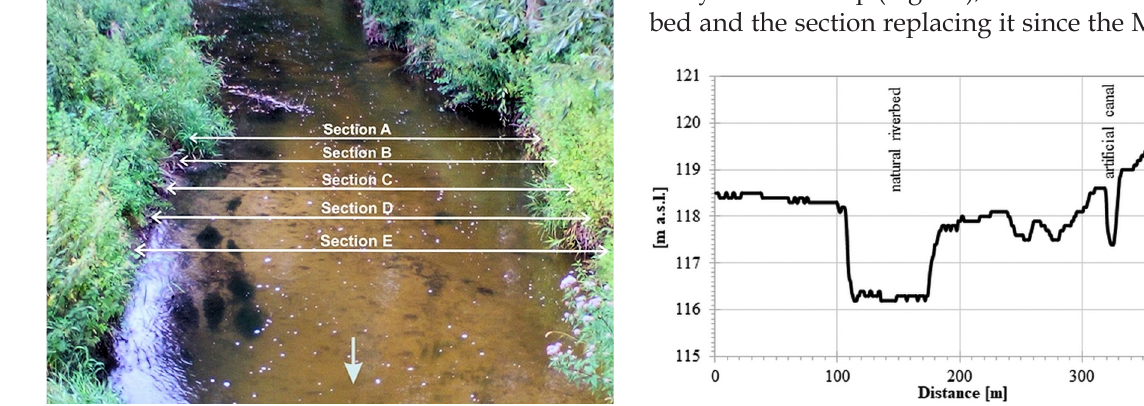
Fig. 6. Place of measurements of the hydraulic gradient on the straight section of the Moszczenica River (the arrow shows the direction of the river